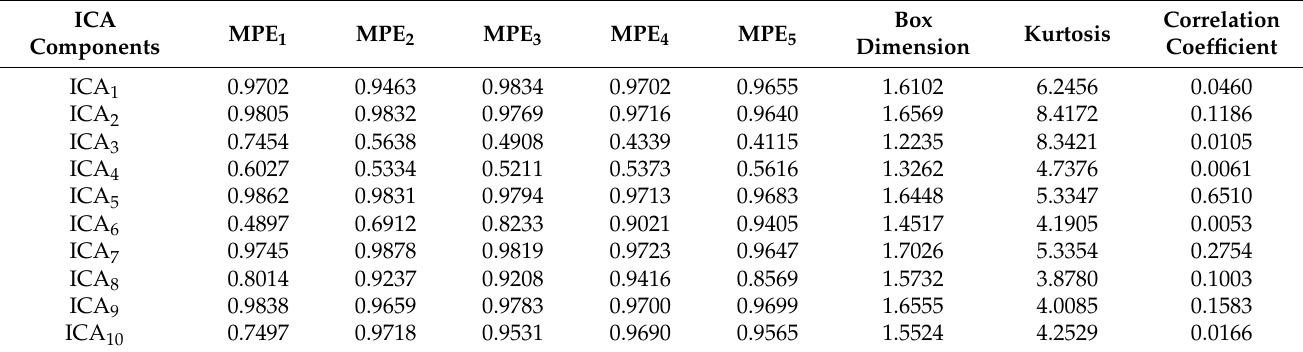
Figure 7. Ten ICA components after CEEMDANICA for severe inner ring fault. Table 3. Index values of different ICA